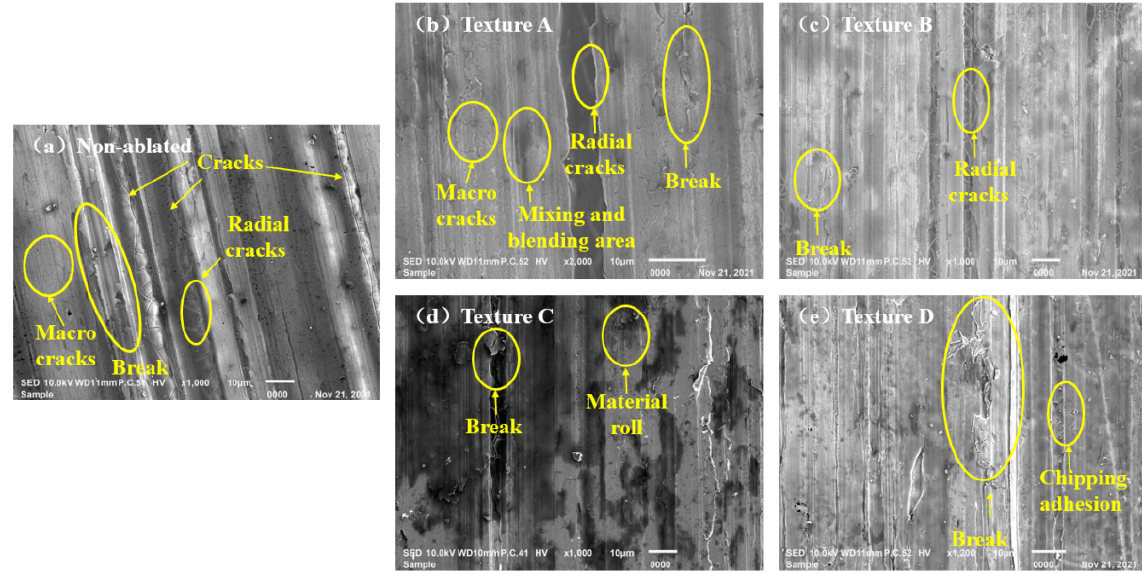
Figure 7. SEM morphology of different texture surfaces after grinding; ( a ) non-ablated workpiece; ( b ) texture A; ( c ) texture B; ( d ) texture C; ( e ) texture D.